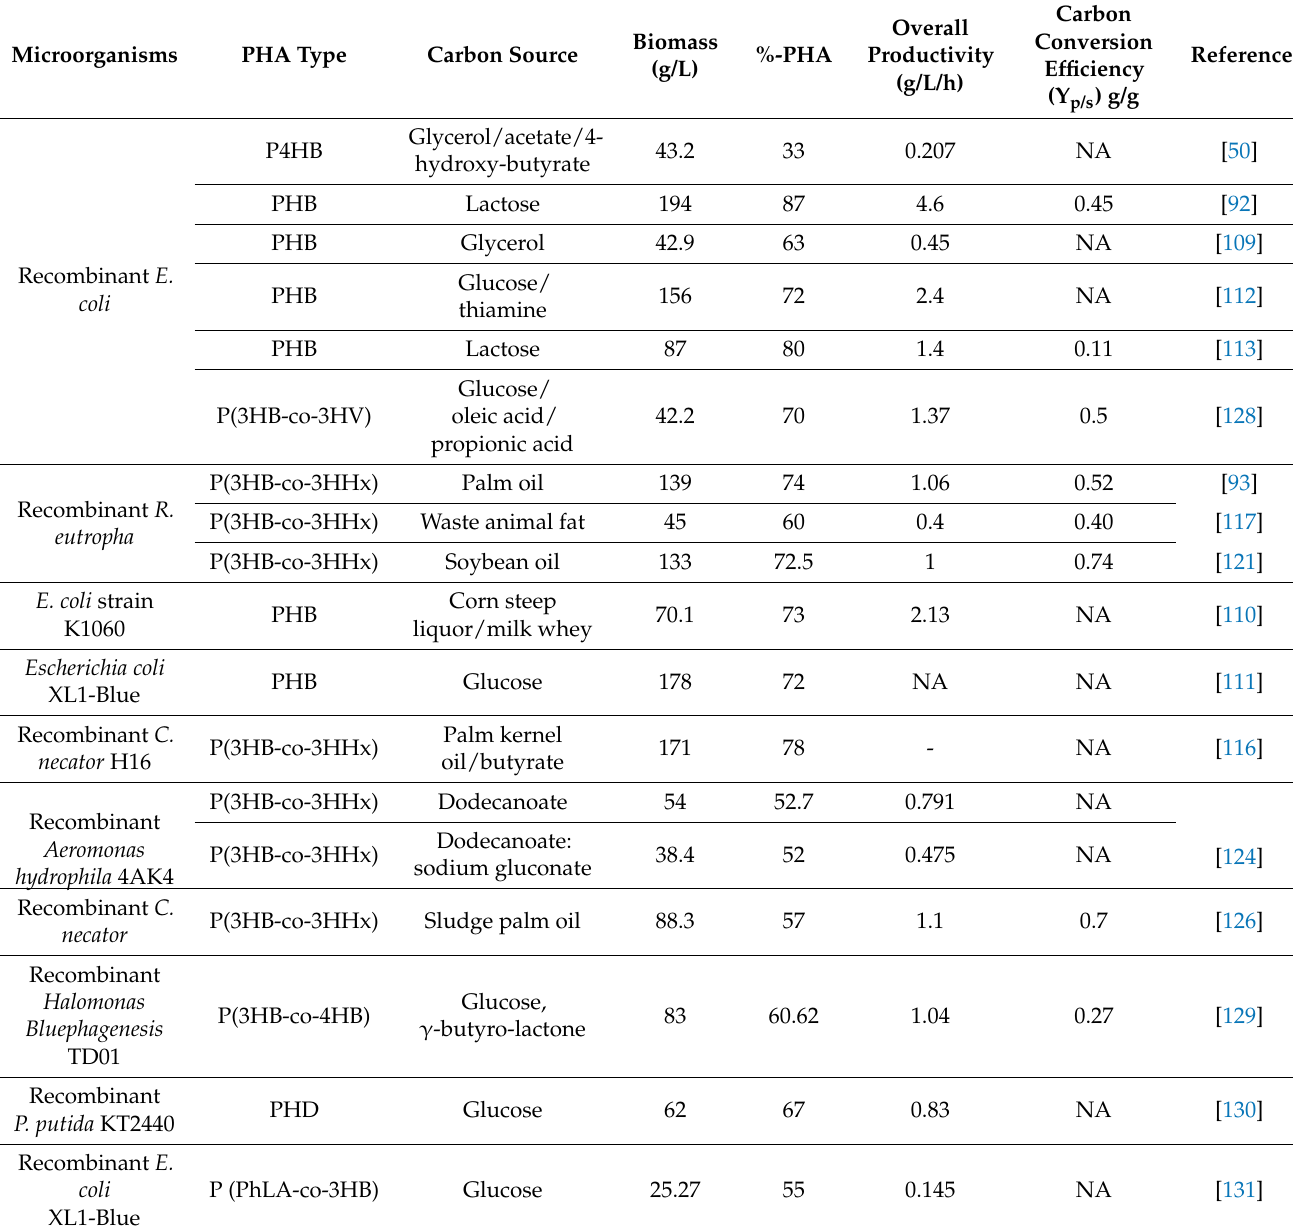
Table 4. PHA production by recombinant starins under HCDC